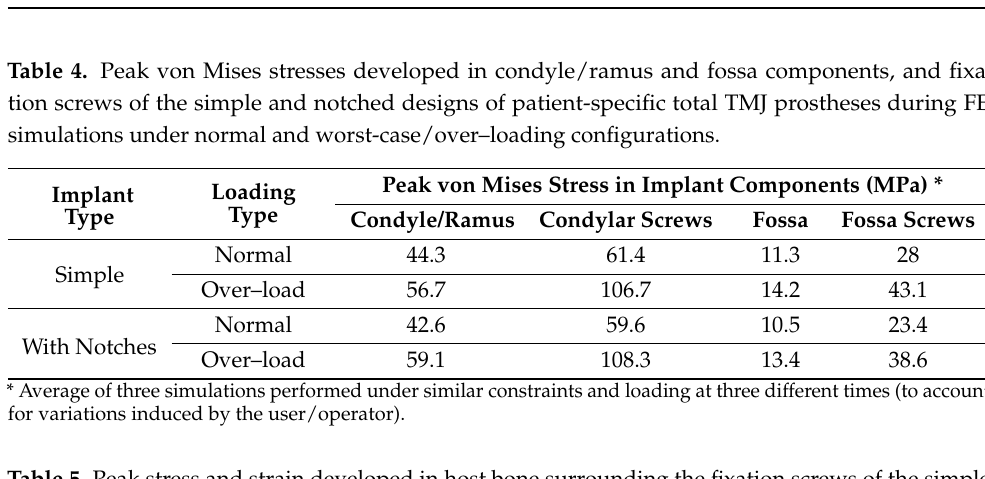
Table 5. Peak stress and strain developed in host bone surrounding the fixation screws of the simple and notched designs of patient-specific total TMJ prostheses during FE simulations under normal and worst-case/over-loading